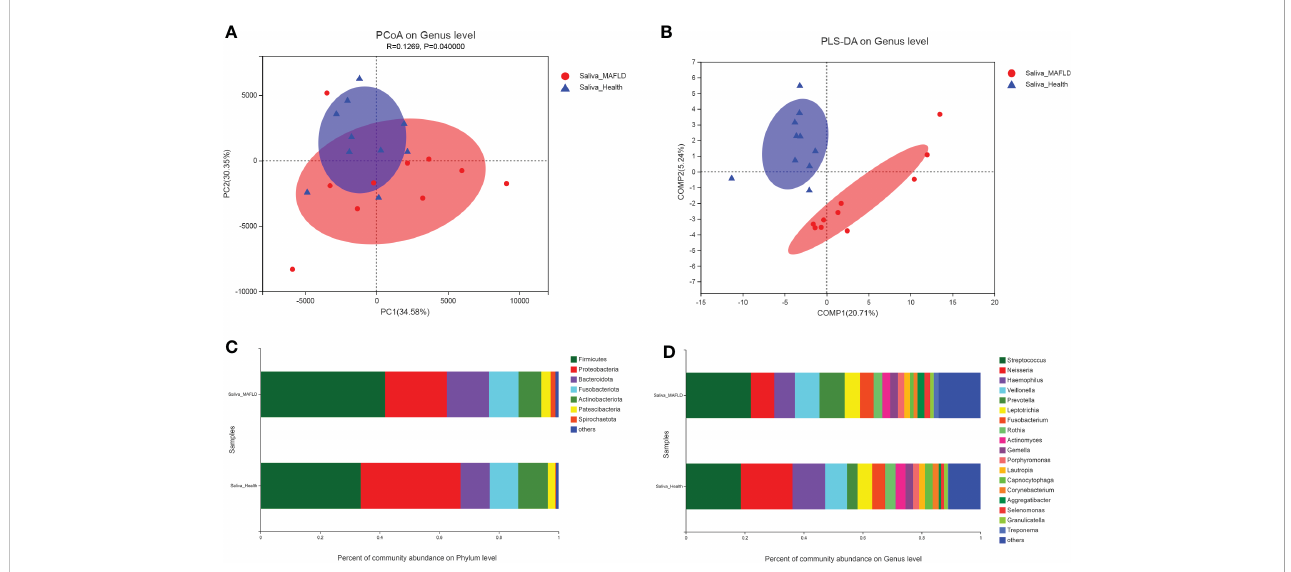
FIGURE 1 Comparison of salivary microbiota structures in the metabolic-associated fatty liver disease (MAFLD) and control groups. (A) Euclidean principal coordinates analysis (PCoA) at the genus level. (B) Partial least squares discriminant analysis (PLS-DA) at the genus level. (C) Microbial community structures at the phylum level. (D) Microbial community structures at the genus level.